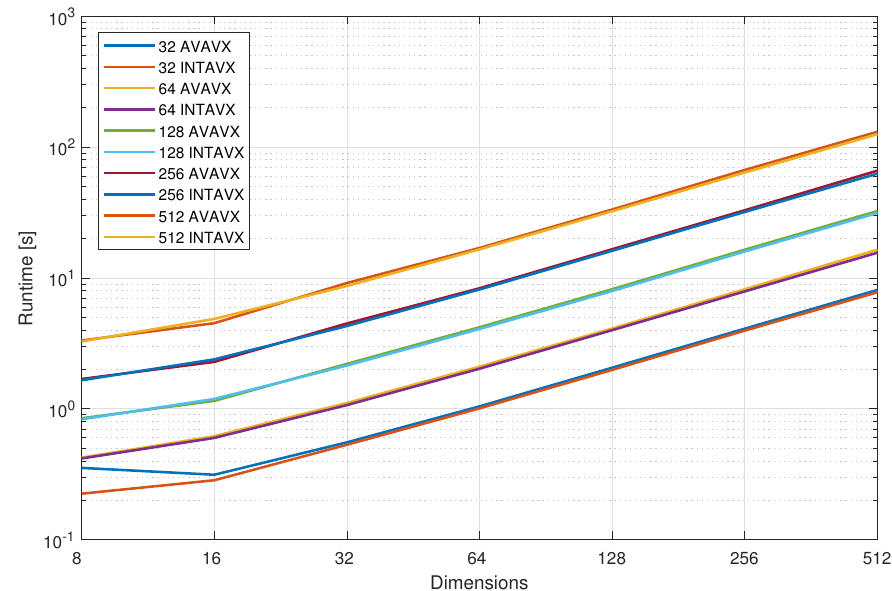
Figure 1. Runtime performance on benchmark suite—various configurations of particles, and dimen- sions.